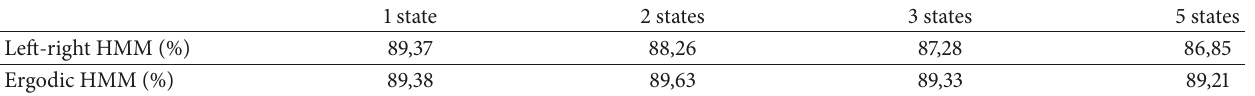
Table 4: The results of ergodic and left-right HMMs for detecting sentence level